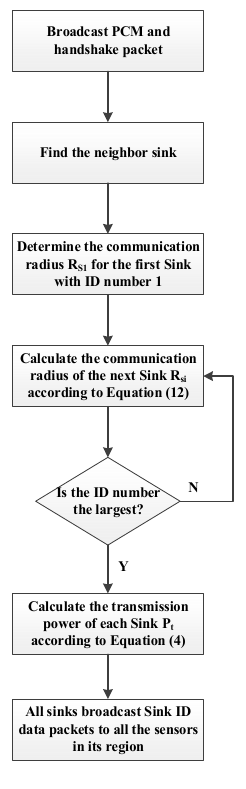
Figure 7. Procedure of DPCA algorithm.